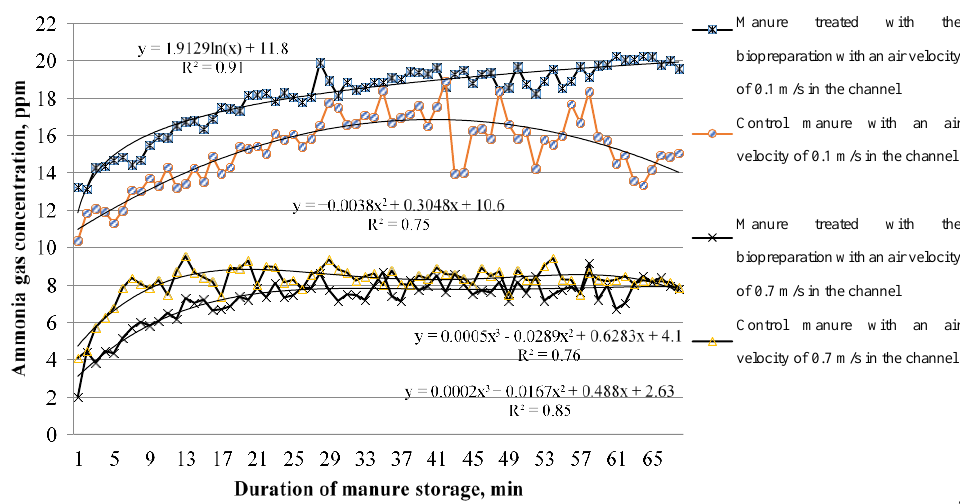
Figure 8. Change in ammonia concentration in the wind tunnel with the addition of the manure treated with the biopreparation and the control manure without additive at two different ventilation velocities.